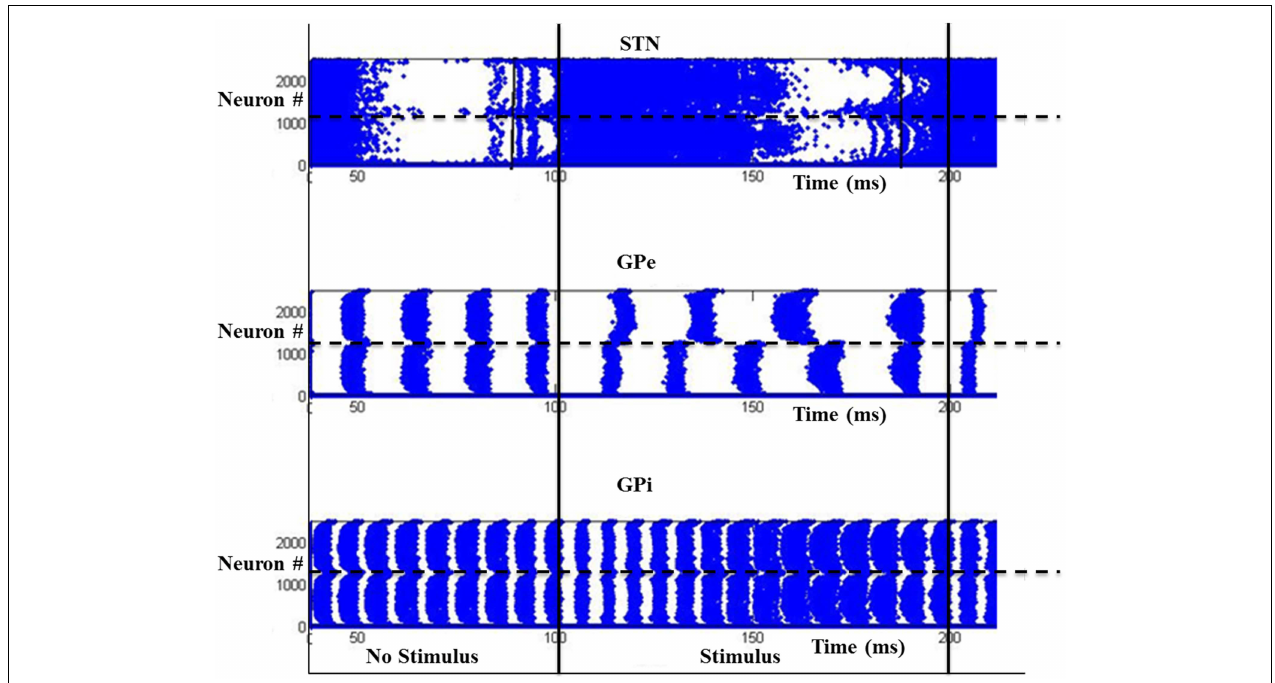
FIGURE 10 | Activity of the model at low DA ( = 0.1) with high firing rate in GPi activity where x-axis represent the time of spiking and y-axis is the spatial representation of 2500 neurons. S1 and S2 are the two stimuli given spatially to the striatum.